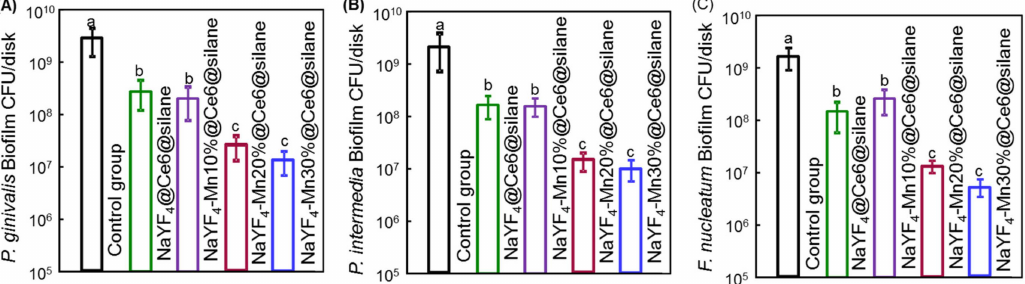
Figure 5. CFU counts of 4-day biofilms of ( A ) P. gingivalis , ( B ) P. intermedia and ( C ) F. nucleatum after PDT application (mean ± sd; n = 6). Nanoparticles with Mn doping would significantly decrease the CFU counts of all three-species biofilms. Note the log scale for the y-axis. Dissimilar letters indicated significant di ff erences between each group ( p <